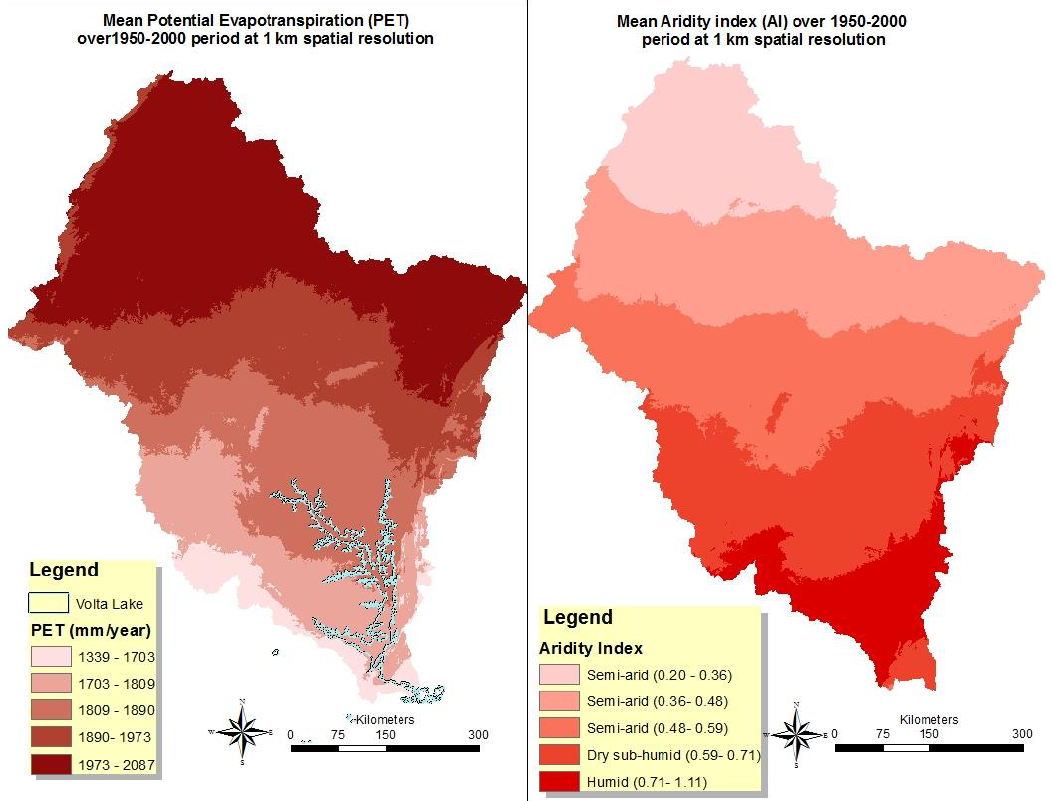
Figure 5. Annual potential evapotranspiration (PET) and aridity index (AI) profile of the Volta Basin.